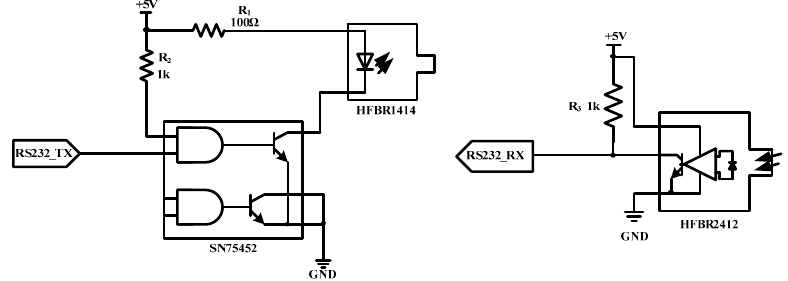
Figure 5. The schematic of the RS232–Fiber communication circuit.